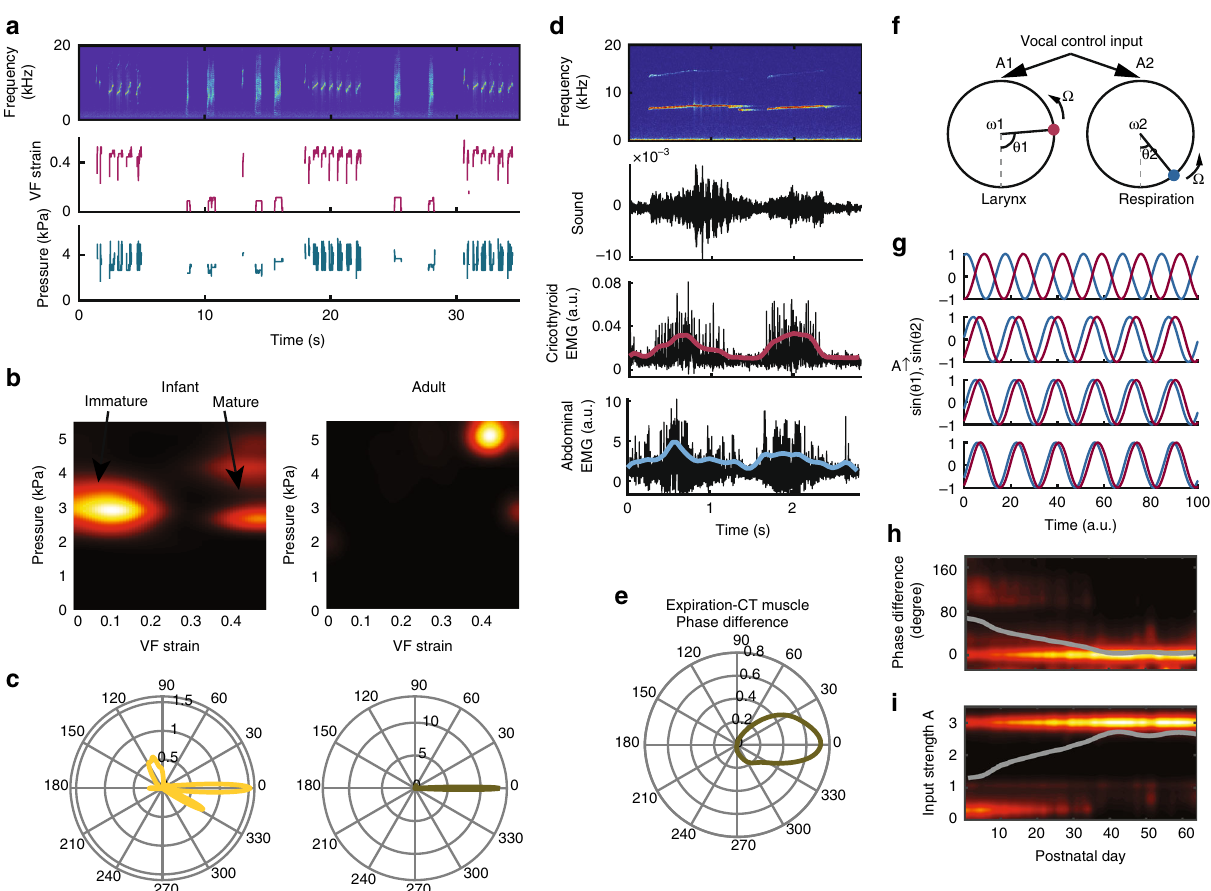
Fig. 5 Vocal maturation requires the development of motor control. a An exemplar showing the reverse-engineering of vocal fold strain and subglottal pressure from a sequence of infant vocalizations. b The probability density of the infant and adult vocal control parameters in the space of subglottal pressure vs. vocal fold strain. A signi fi cant portion of the infant vocalizations were produced at the low-strain region, which is absent in the adult vocalizations. c The distributions of the phase difference between pressure and vocal fold strain during the production of infant and adult vocalizations. d EMG recordings at the right cricothyroid (CT) muscle and the abdominal muscle (for expiration) during adult phee call production. The amplitude modulation of the EMG signals is shown in bold (a.u., arbitrary units). e The distribution of the phase difference between the amplitude modulation of the expiratory muscle activity (corresponding to positive subglottal pressure) and the CT muscle activity. f A model for oscillators representing the respiratory and the laryngeal CPGs coupled with a common vocal control input. A 1,2 are the input strengths, ω 1,2 are the intrinsic angular frequencies, θ 1,2 are the phases of the two oscillators and Ω is the angular frequency of the input oscillator. g The phase difference decreases as the input strength A increases in amplitude. h The probability density of the phase difference shifts towards zero over the fi rst 2 months. i The probability density of the input strength A increases over the fi rst 2 months. The gray traces are the fi tted